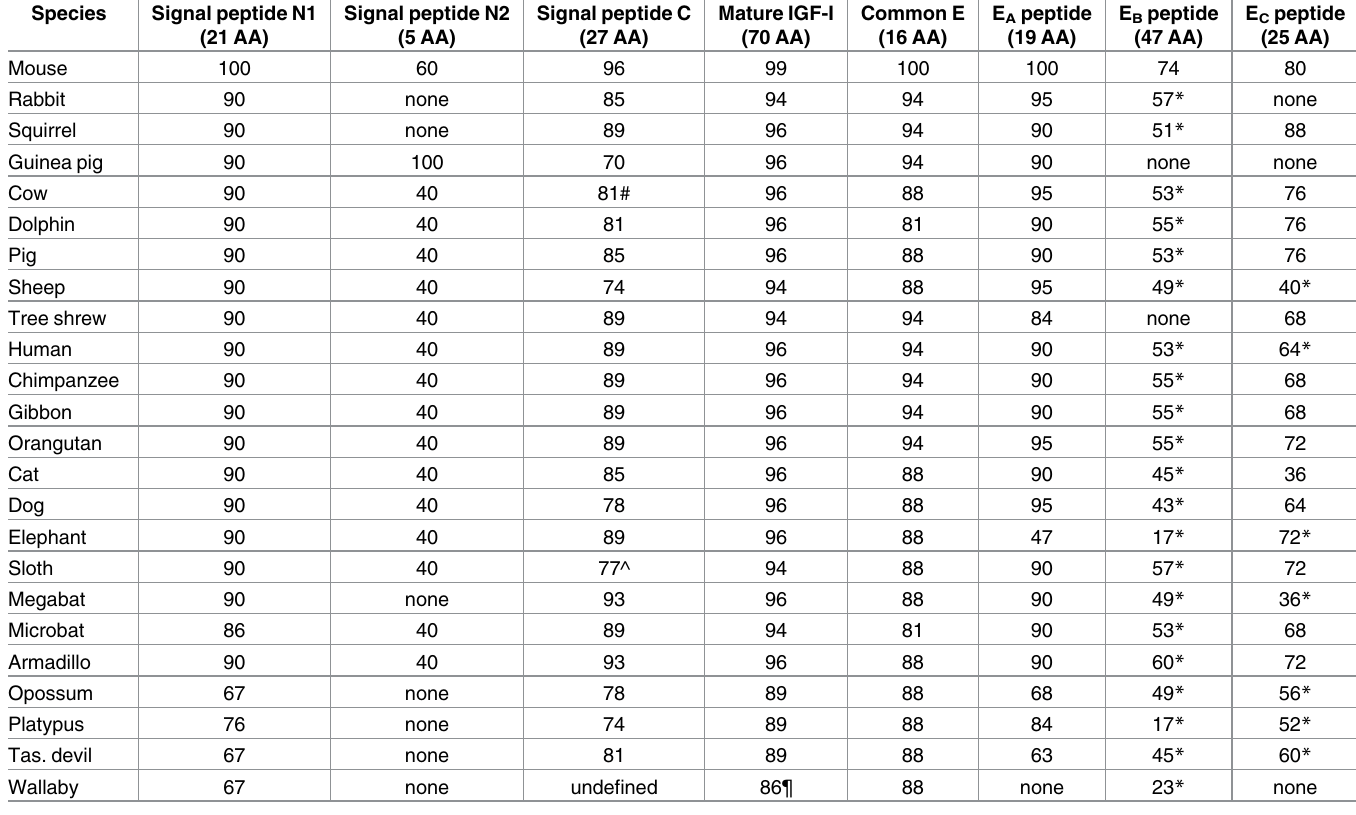
Table 4. Amino acid identities with rat IGF1